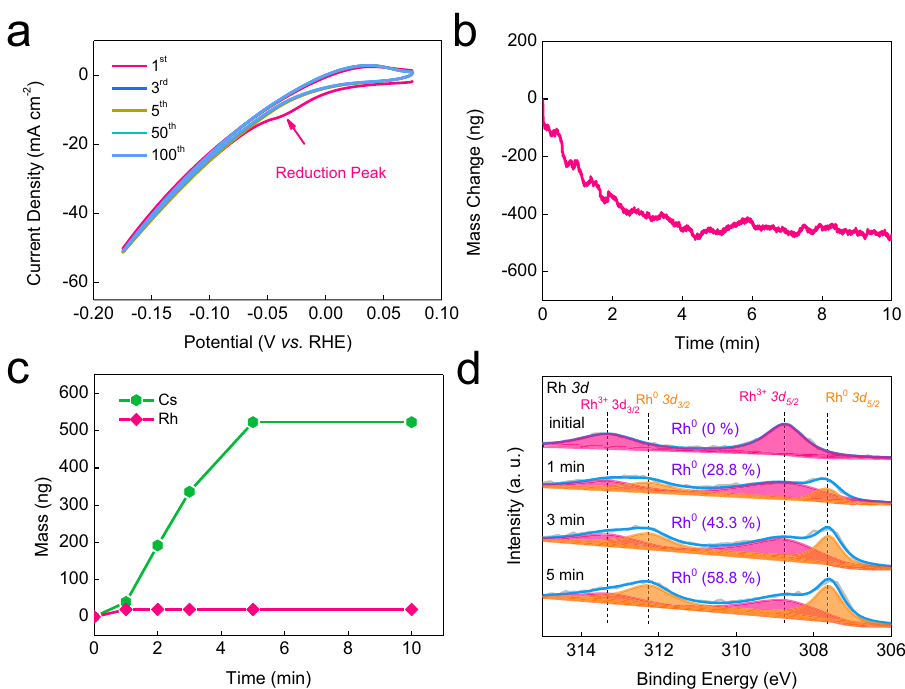
Fig. 3 | Reconstruction of clusters Cs 3 Rh 2 I 9 /NC into Rh nanoparticles on NC. a TheCVcurvesfrom1 st to100 th cycleat100mVs − 1 forCs 3 Rh 2 I 9 /NCin1.0MKOH. b Mass change of the Cs 3 Rh 2 I 9 /NC electrode monitored by in situ EQCM experiment. c ICP-MS of the Cs and Rh contents in the electrolyte at different